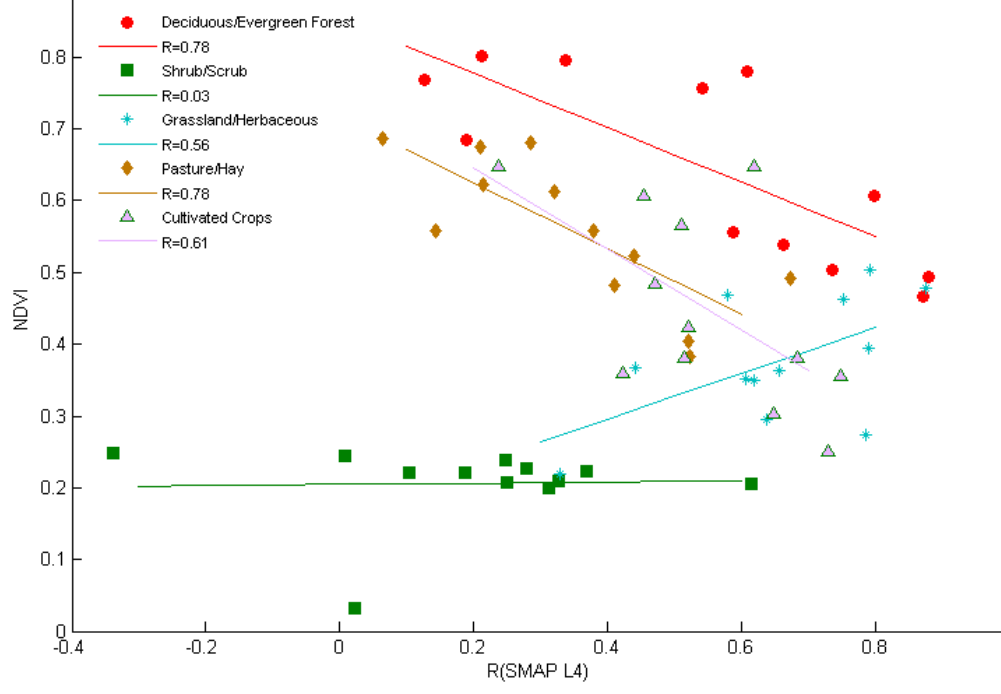
Figure 15. The comparison between NDVI and SMAP L4 evaluation results against in situ (R).